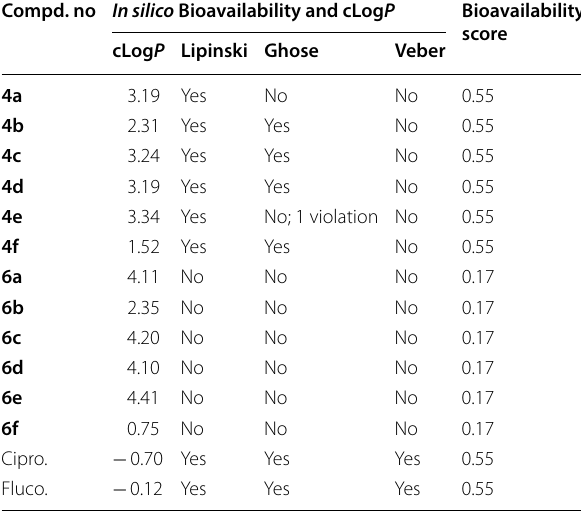
Table 4 In silico bioavailability prediction and cLog P value Compd. no In silico Bioavailability and cLog